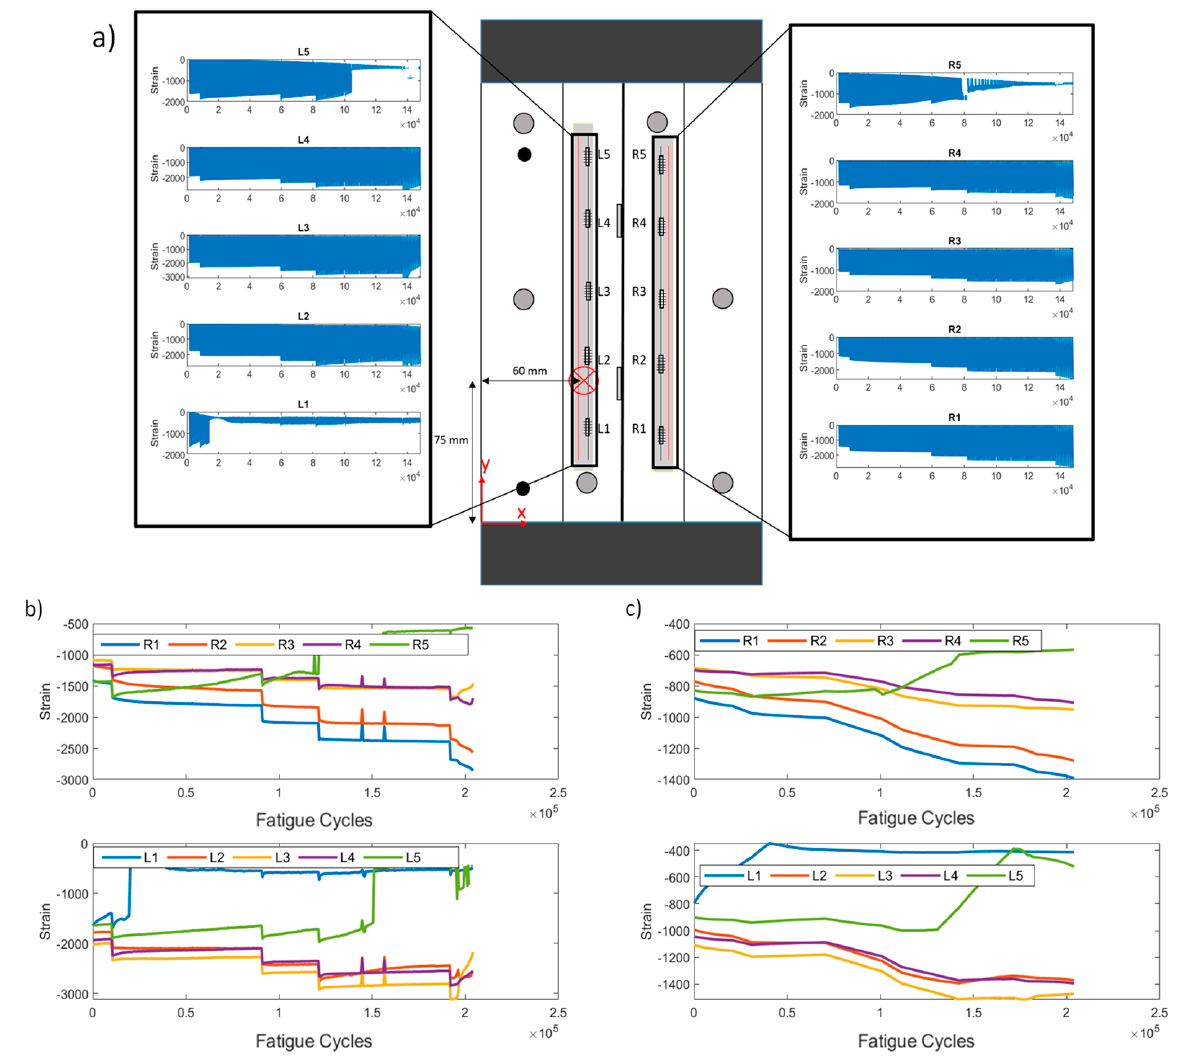
Figure 13. Variable amplitude test specimen VA-1. ( a ) Sensor and damage locations and raw strain data for each FBG; ( b ) extracted maximum data from each quasi-static vs. cycles (pre-processing method 1); ( c ) extracted mean data for each quasi-static vs. cycles (pre-processing method 2).